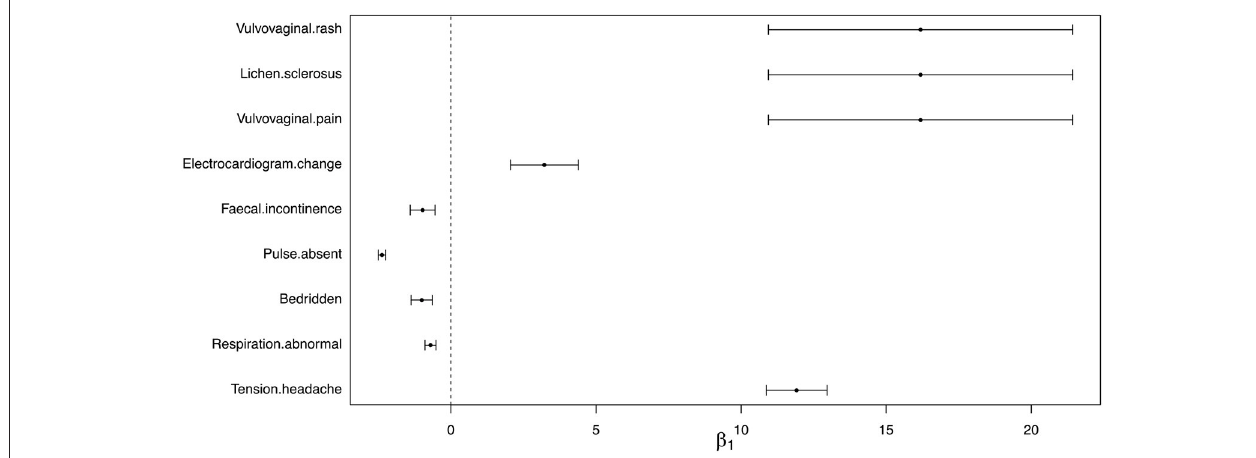
FIGURE 3 | Estimated effect size and 95% confidence interval of reporting AEs between non-Hispanic White female and other race/ethnicity